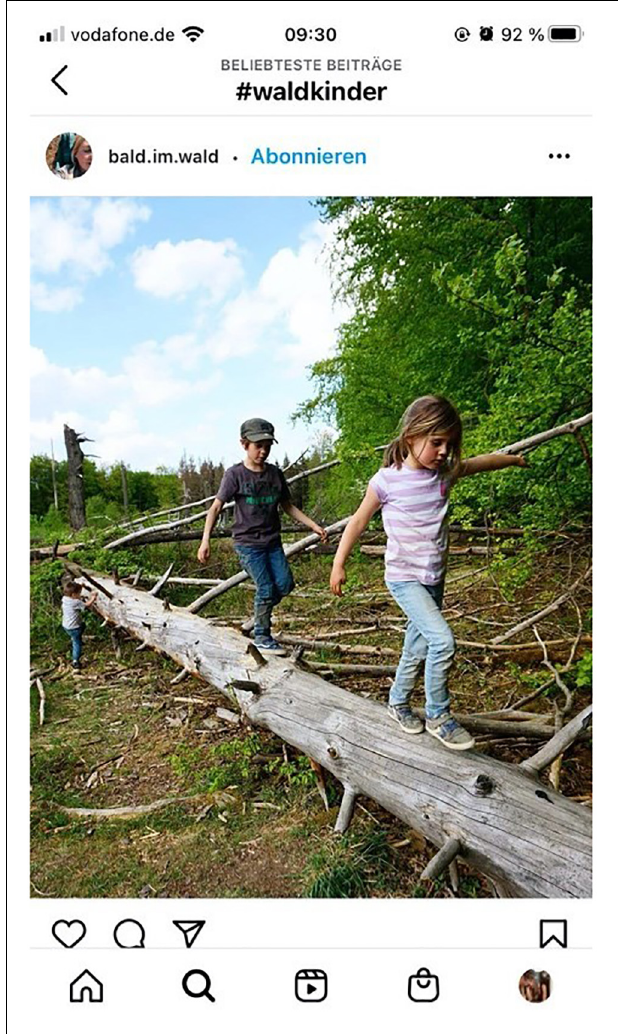
FIGURE 5 | Forests as playground (source: